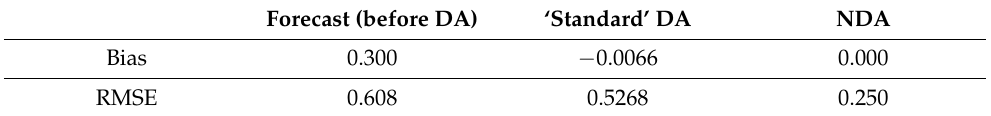
Table 1. Errors in the child model outputs before and after data assimilation. Forecast (before